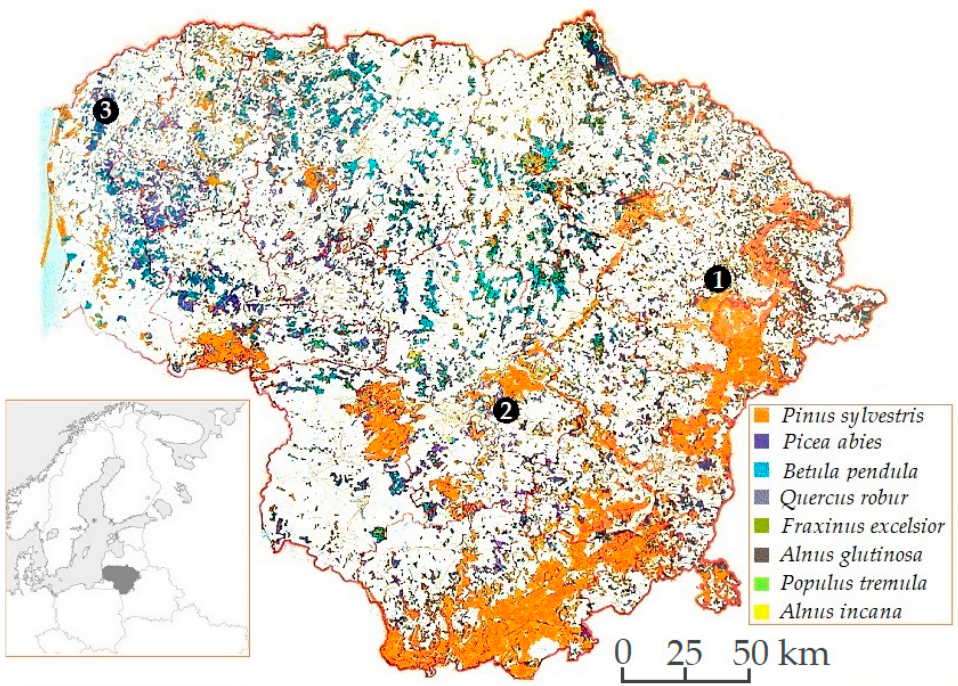
Figure 1. Map of Lithuania (position on the north European map is shown in the lower left corner) showing distribution of forests and tree species (colors of different tree species are shown in the lower right corner). Study sites are indicated by black circles and numbered: 1—Labanoras (N 55°14 ′ 3.38 ″ , E 25°33 ′ 21.81 ″ ), 2—Dubrava (N 54°51 ′ 47 ″ , E 24°4 ′ 0.75 ″ ), and 3—Lenkimai (N 56°11 ′ 1.99 ″ , E 21°18 ′ 42.23 ″ ). The map was reproduced with permission from FORESTGEN, www.forestgen.mi.lt (accessed on 25 January 2023).